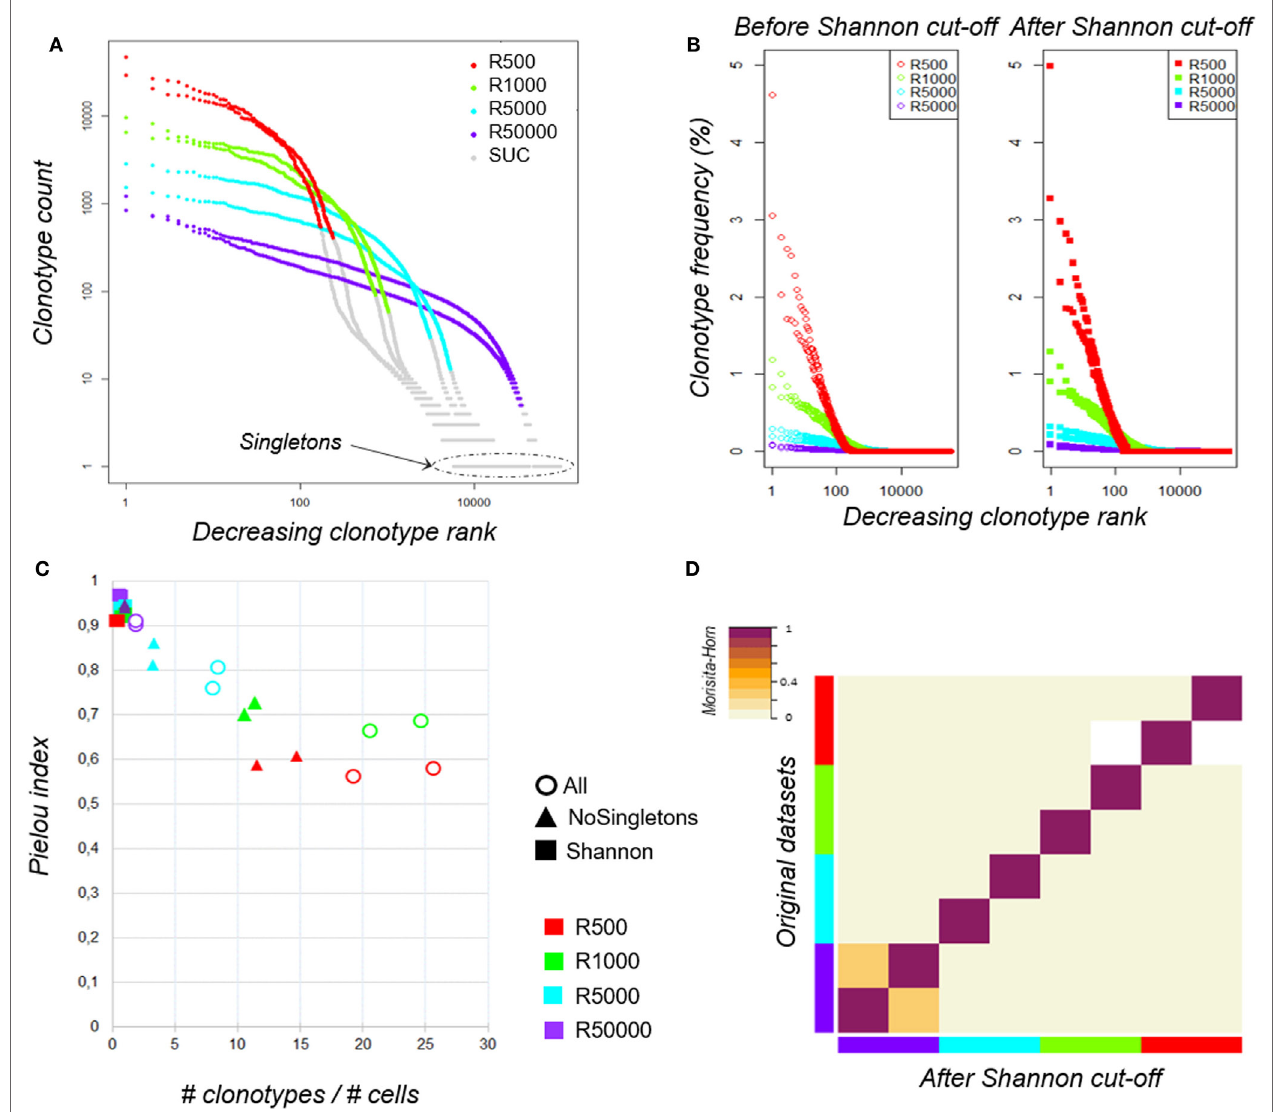
FigUre 2 | Clonotype distributions before and after data filtering. (a) TRB clonotype counts of the eight aliquots according to sampling size. Within each dataset, clonotypes were ranked according to their counts from the most to the least predominant (decreasing clonotype rank) and their abundance (clonotype count). Both axes are log-scaled. Plots were colored according to the sampling size: “500 cells” in red, “1,000 cells” in green, “5,000 cells” in cyan, and “50,000 cells” in purple. Clonotypes filtered out using the Shannon index (see main text) are colored in gray [scarce uninformative clonotypes (SUC)]. (B) TRB clonotype distributions of the eight aliquots before and after data filtering. Before (left) and after (right) filtering each dataset using the Shannon index as threshold, clonotypes were ranked from the most to the least predominant (decreasing clonotype rank) according to their relative frequencies (clonotype frequency). The X-axis is log-scaled. Distributions were colored according to the sampling size as previously. (c) Impact of clonotype filtering on the clonotype distribution evenness. The ratio between the number of clonotypes and the number of cells ( x -axis) was calculated for each aliquot before (circles) and after clonotype filtering either by removing only singletons (triangles) or using the Shannon index as a threshold (squares). For each dataset, the Piélou evenness index was calculated ( y -axis). Aliquots are identified according the sampling size as previously. (D) Similarity between datasets before and after Shannon filtering. The Morisita–Horn similarity index between all pairs of datasets is color-coded according to the indicated scale before (lower half-triangle) and after (upper half-triangle) Shannon filtering. Aliquots are identified according to sampling size as